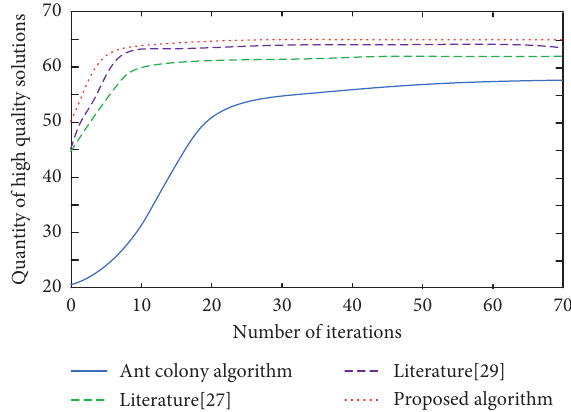
Figure 8: Comparison of the number of high-quality solutions of the four